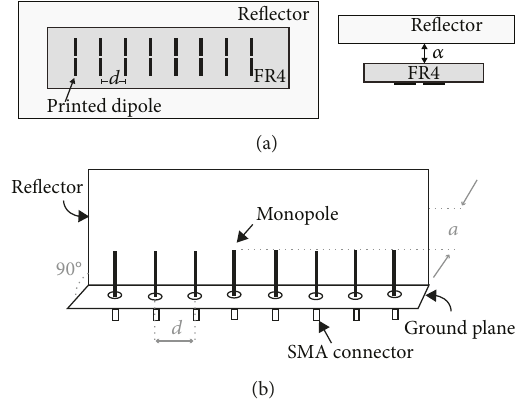
Figure 10: (a) The 8-printed dipole (the FR4 is 59 4 × 6 4 and the re fl ector 59 4 × 21 ) and (b) the 8-monopole (the ground plane is 59 4 × 8 9 and the re fl ector is 59 4 × 21 ) antenna array. The dimensions are given in cm.